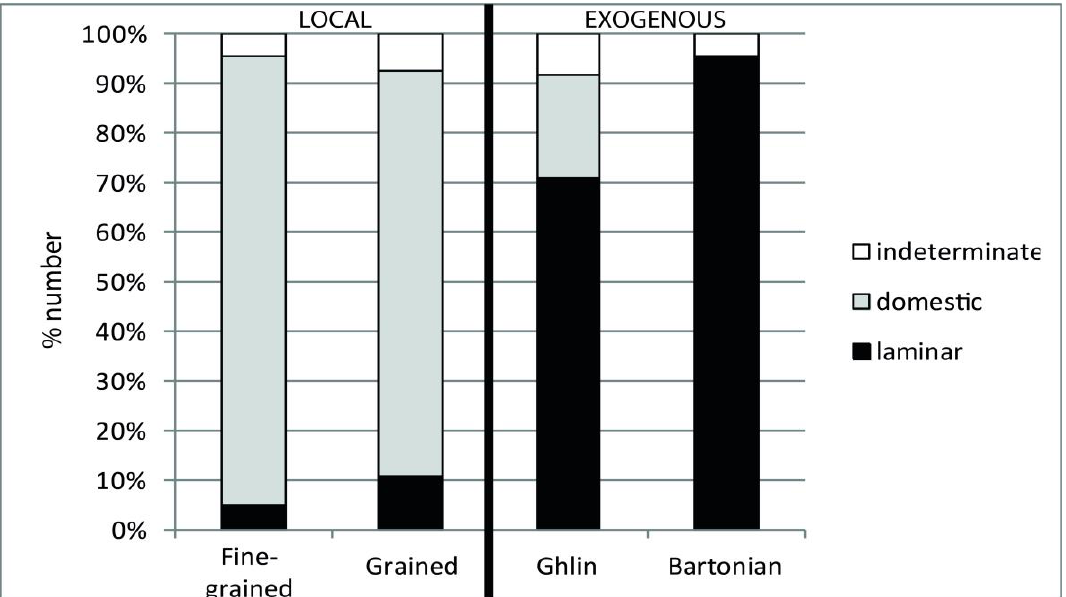
Figure 5. Representation of the part of the different productions according to the different raw materials exploited.